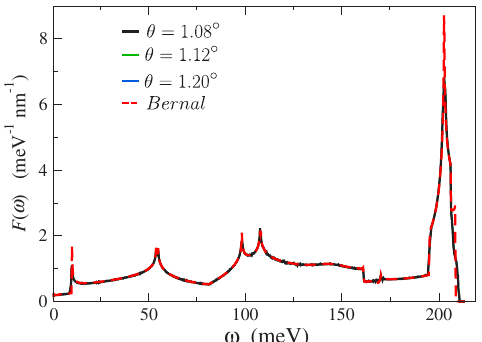
FIG. 4. Phonon density of states F ð ω Þ for Bernal-stacked bilayer graphene at zero twist angle (red dashed line) and fully relaxed TBLG at θ ¼ 1 . 20 , 1.12, 1.08 (blue, green, and black lines).